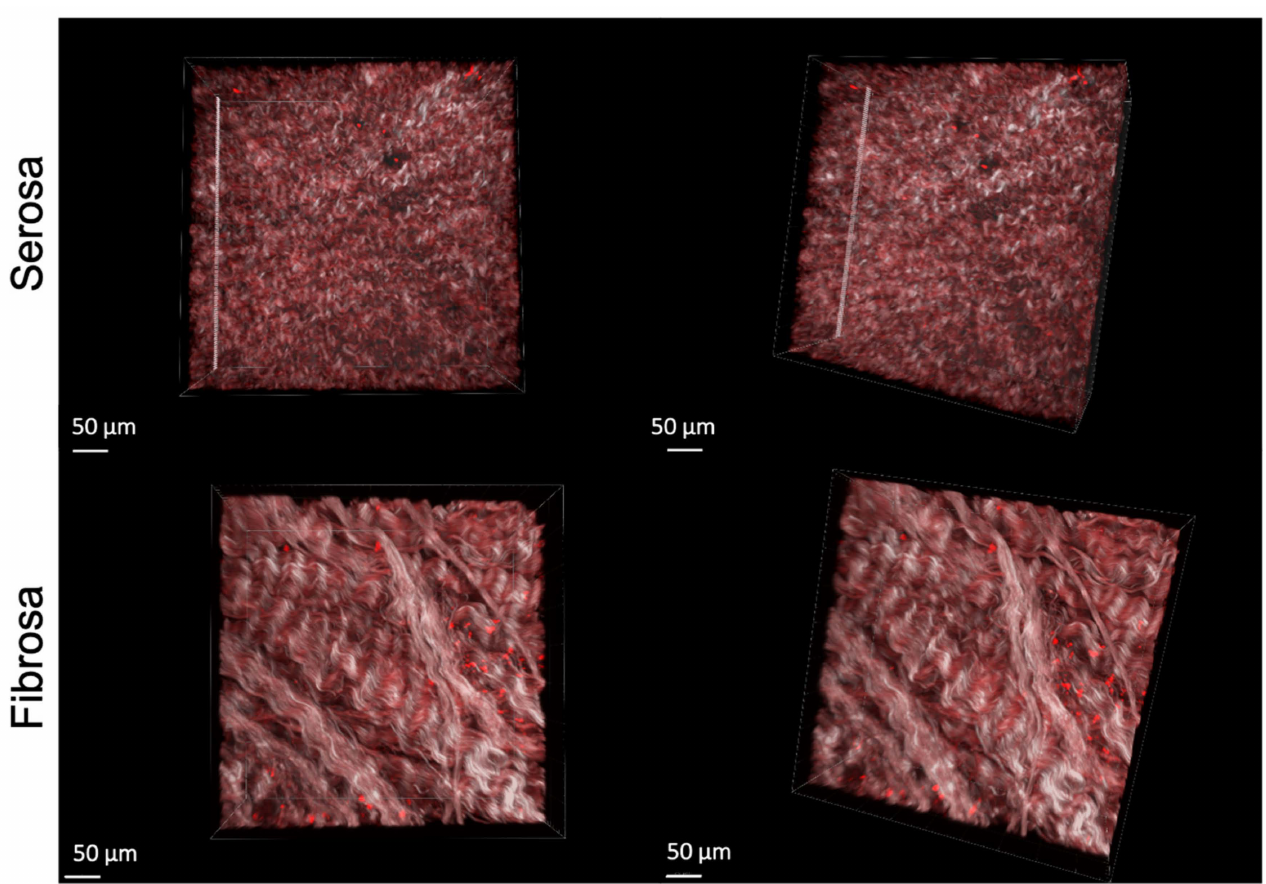
Figure 2. 3D representation of RhodREDV functionalized pericardium. The images were obtained by overlapping the Second Harmonic Generation (SHG) signal relative to collagen and the RhodREDV signal at 800 nm.